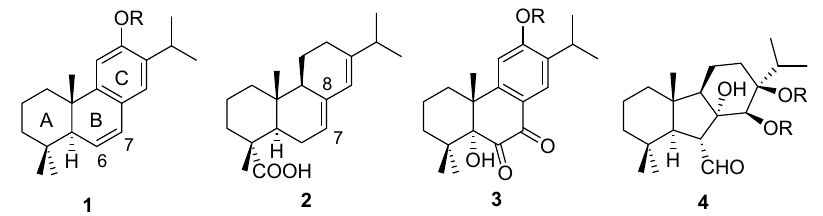
Figure 2. Abietane-type compounds ( 1 – 2 ) and their synthetic derivatives ( 3 – 4